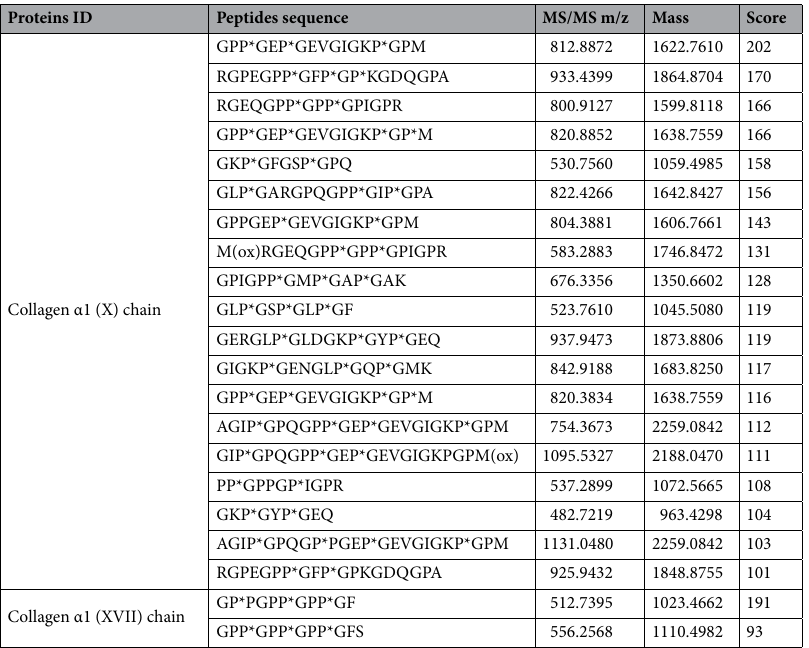
Table 2. Identified collagen peptides in ESM hydrolysate by LC–MS/MS analysis. P *: hydroxyproline. The data was afforded on the MaxQuant (ver. 1.6.6.0) and Gallus gallus total protein database which was downloaded on 11th Jun 2021 from Uniprot (https:// www. unipr ot.